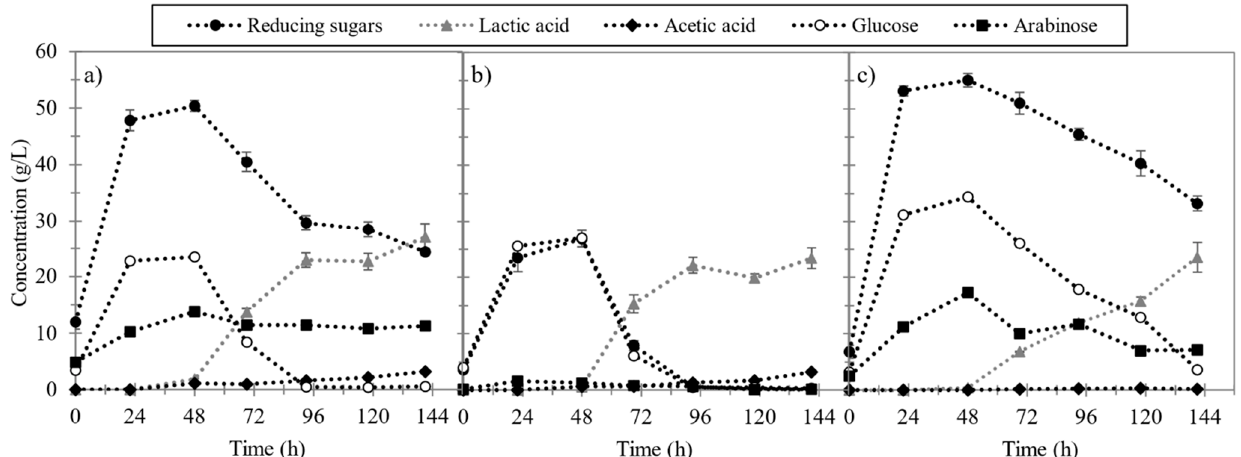
Figure 2. Enzymatic hydrolysis and lactic acid fermentation of non-pretreated ESBP ( a ), biologically pretreated ESBP ( b ) and alkaline hydrogen peroxide pretreated ESBP ( c ): reducing sugars concentration (black circle), lactic acid concentration (grey triangle), acetic acid concentration (black diamond), glucose concentration (white circle) and arabinose concentration (black square).